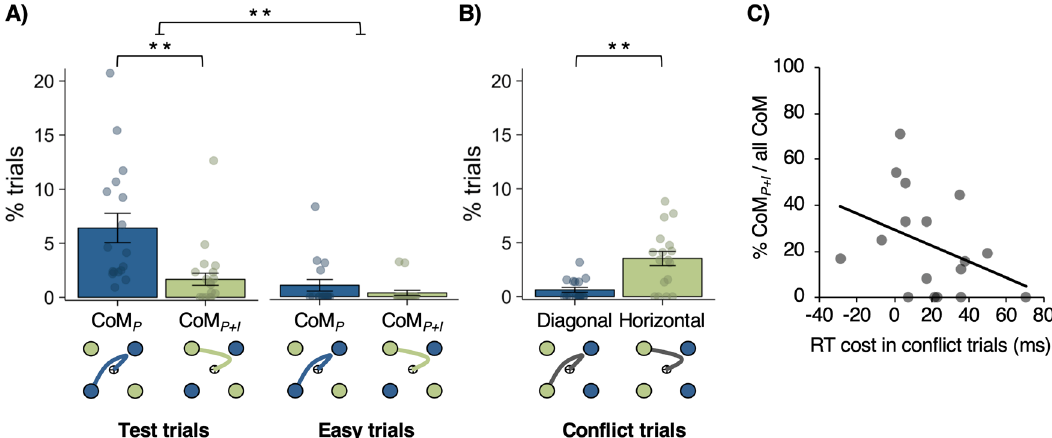
Fig. 2 Changes of Mind (CoM) in Exp. 1 ( n = 17 participants). A Percentage of trials classi fi ed as perceptual CoM (CoM P ; blue) and perceptual + intentional CoM (CoM P + I ; green) in test and easy trials. B Percentage of con fl ict trials with diagonal (blue) and horizontal (green) movement corrections of partial errors that were induced by mismatches between colour intentions and dot-motion direction. In both A and B , data are presented as mean values ± 1 SEM (** p < 0.001). Dots represent data points from individual participants. Statistical signi fi cance was obtained using likelihood ratio tests to compare logistic mixed-effects regression models with vs. without the fi xed effects of interest (see “ Methods ” ). No correction for multiple comparisons was performed since all comparisons are orthogonal and were planned prior to data collection. C Correlation across participants between RT costs in con fl ict trials and frequency of CoM P + I (relative to overall percentage of all CoM), ρ (15) = − 0.50, p = 0.043, two-tailed. Source data are provided as a Source Data fi